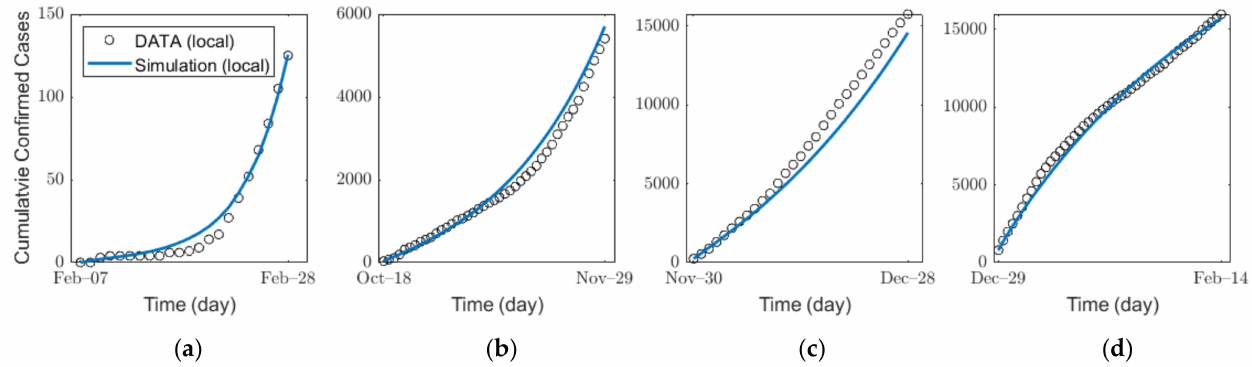
Figure 4. Estimation of the infection probability for different levels of SD: SD level ( a ) 0, ( b ) 1, ( c ) 2, and ( d )